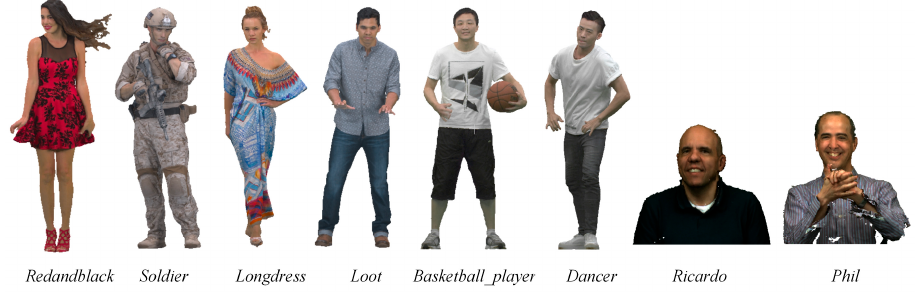
Figure 8. The original point clouds.